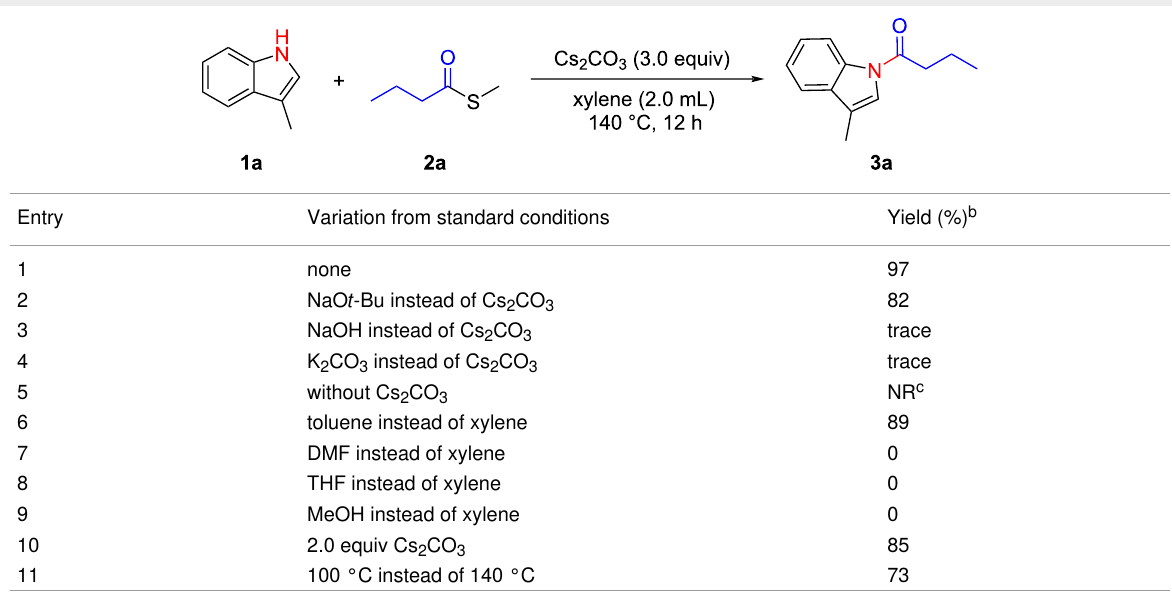
Table 1: Optimization of the reaction conditions a